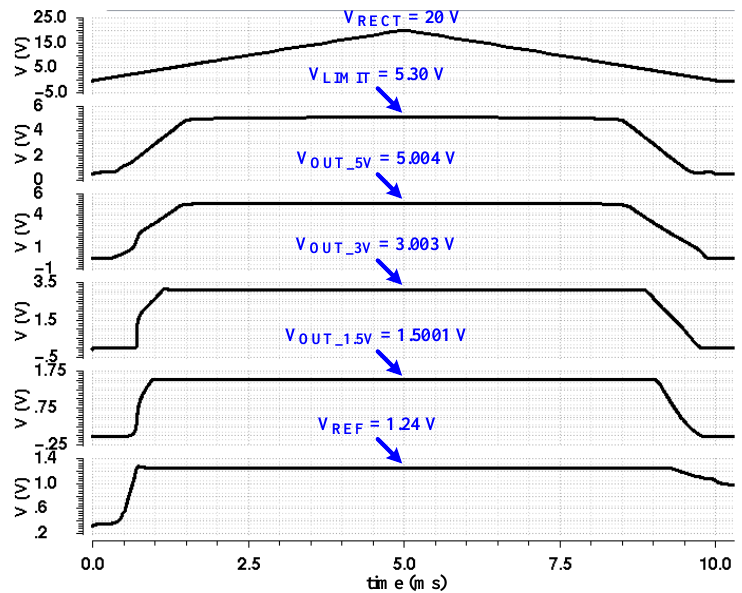
Figure 6. Top simulation results of the proposed power regulated circuit (PRC).